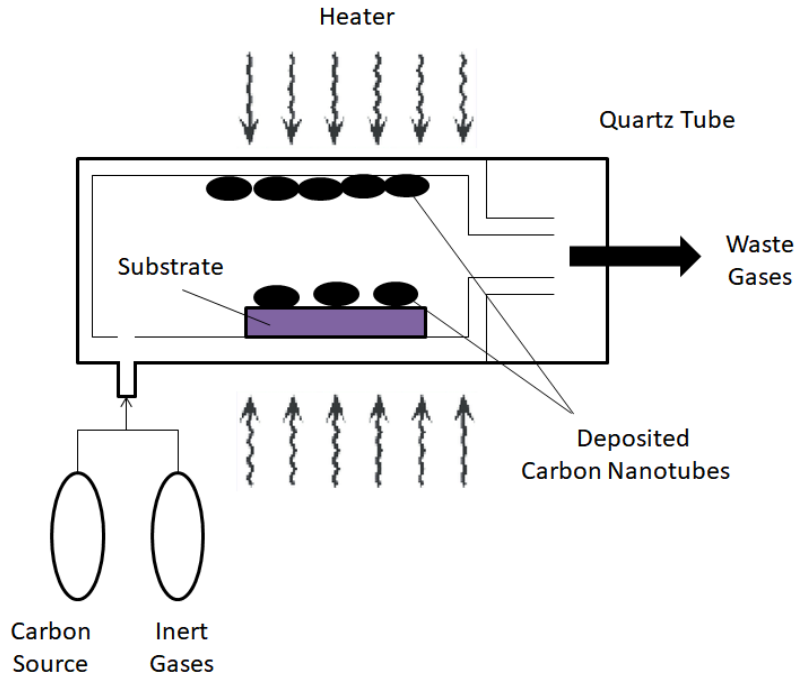
Figure 4. Synthesis of CNTs through CVD.